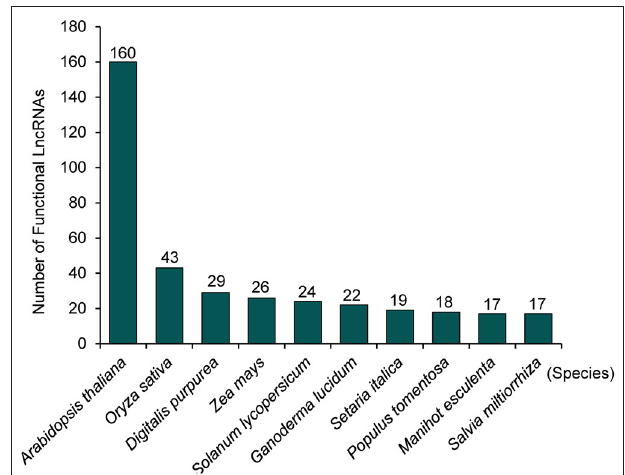
FIGURE 1 | Statistics of the number of functional lncRNAs in top 10 plant species based on the experimentally validated functional lncRNAs in plants, according to EVLncRNA2.0 (Zhou et al.,